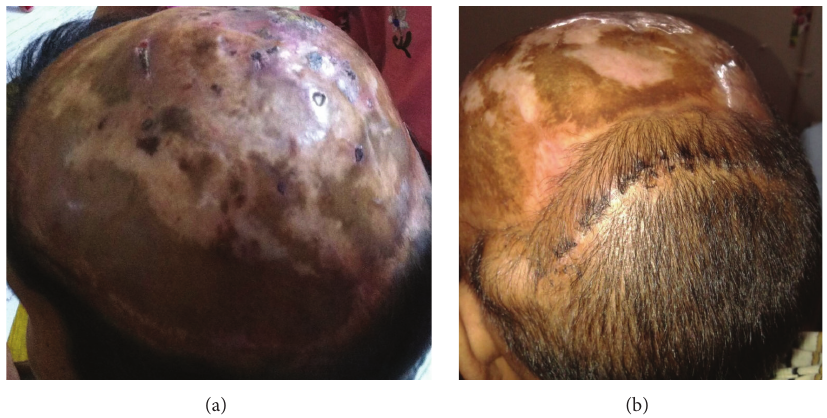
Figure 7: Follow-up showing completely covered scalp tissue (a) and use of tissue expander on the peripheral scalp (containing hair follicles) to cover the bare area